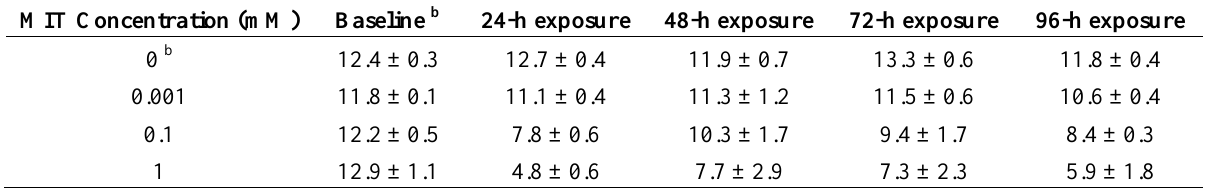
Table 1. Velocity of light gradient-induced locomotion in planaria exposed to various concentrations of monoiodotyrosine (MIT) that inhibits tyrosine hydroxylase (TH), the first and rate-limiting enzyme of dopamine (DA) biosynthesis a